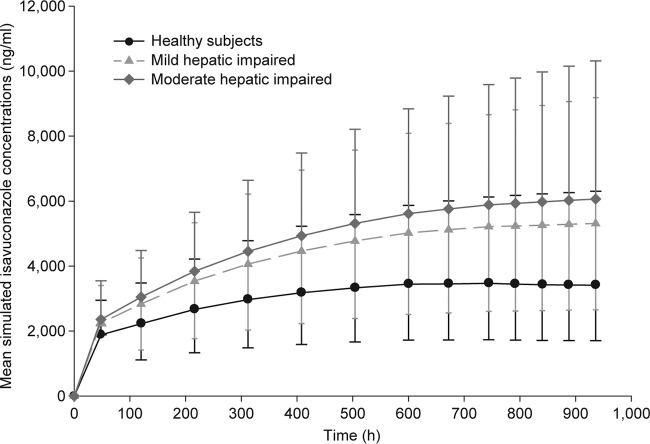
Mean simulated isavuconazole concentrations (with 95% confidence intervals) as a function of time.